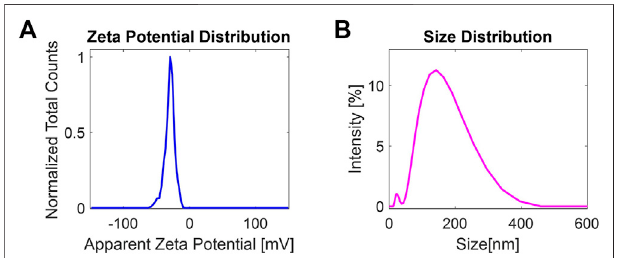
FIGURE 2 | (A) ζ -Potential distribution and (B) size distribution of 2D- MoS 2 produced at a g-force of 1,000